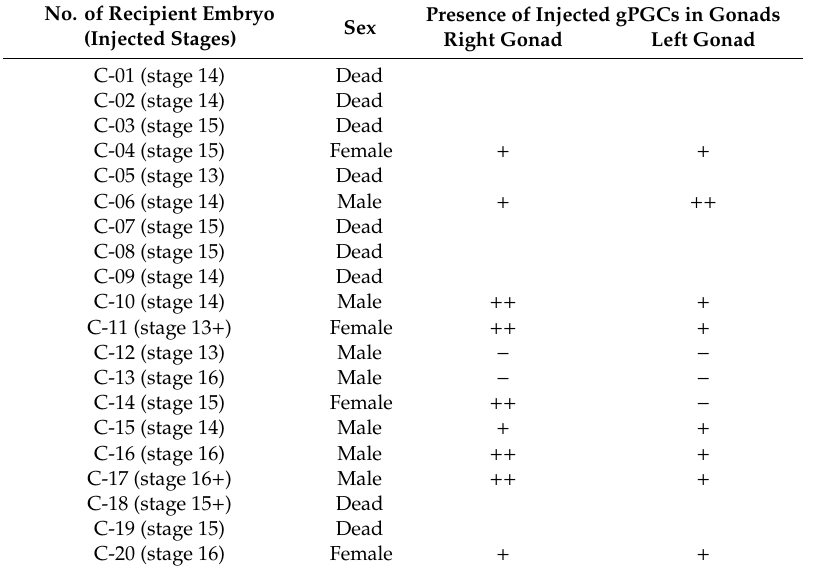
Table legend . C 01–20 = recipient embryos that received cPGCs at the indicated stage 14–16 + H&H; ‘ − ’ no colonization; ‘ + ’ gonad colonized at the moderate level; ‘ ++ ’ highly colonized gonad.